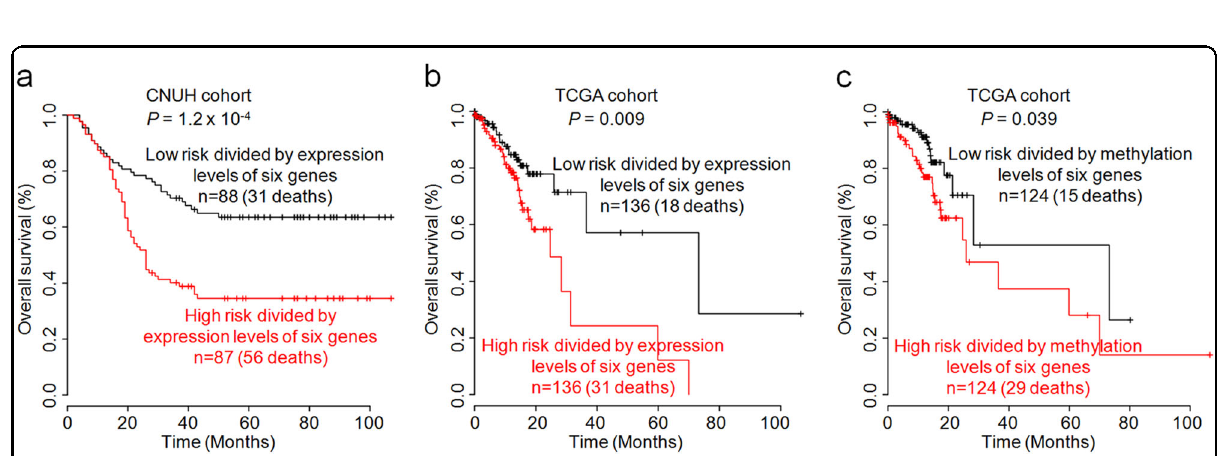
Fig. 7 Survival analysis based on the expression data of the six GI hormone receptors in (a) CNUH and (b) TCGA cohorts and the methylation levels in TCGA cohort ( c ). All statistical analyses were performed by the Kaplan – Meier method and log-rank